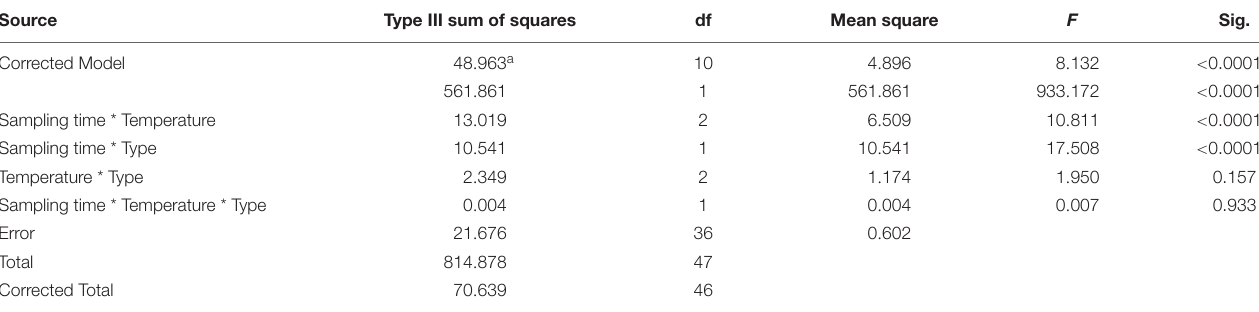
Source Type III sum of squares df Mean square